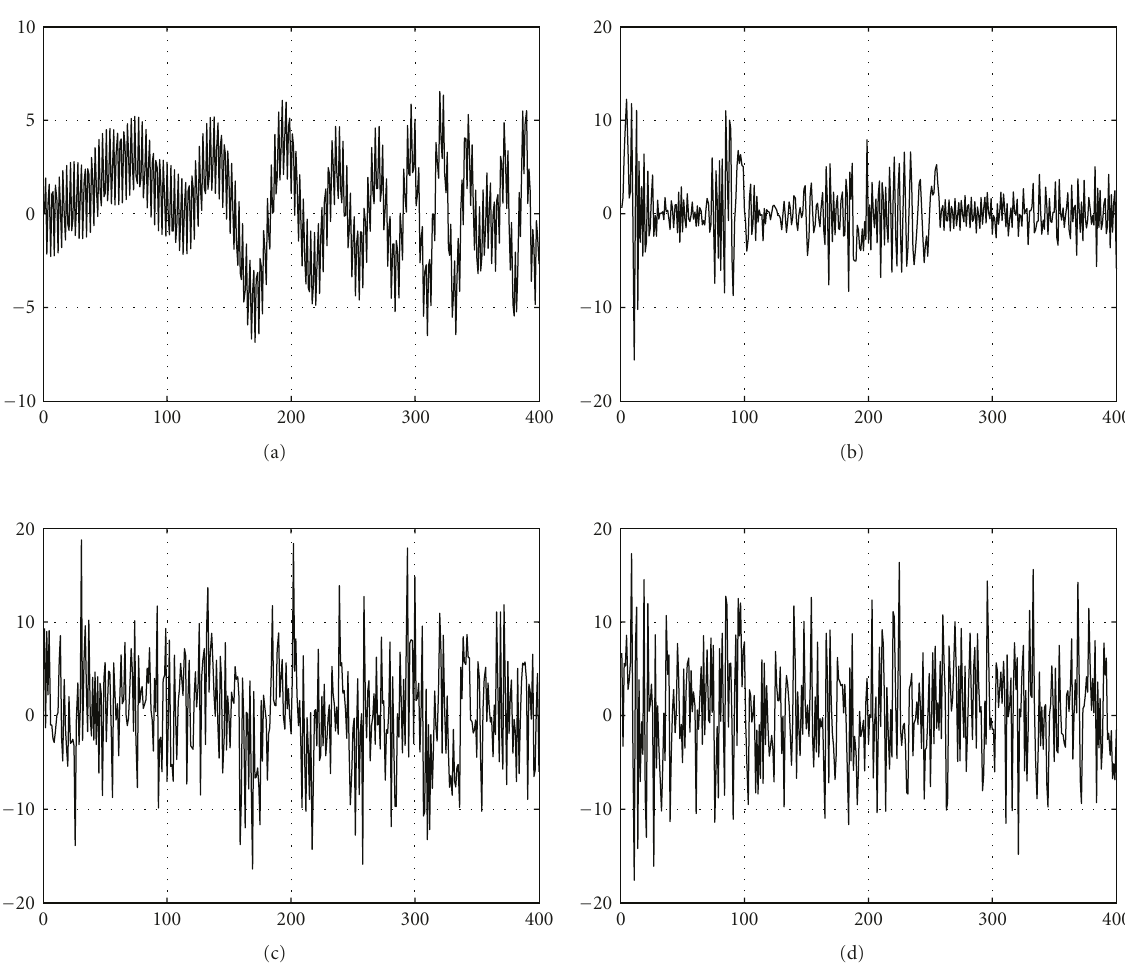
Figure 3: (a) Mishmash signal with length 1024, (b) wavelet coe ffi cients, (c) noisy Mishmash signal with additive white noise, σ w = 5, and (d) noisy coe ffi cients.